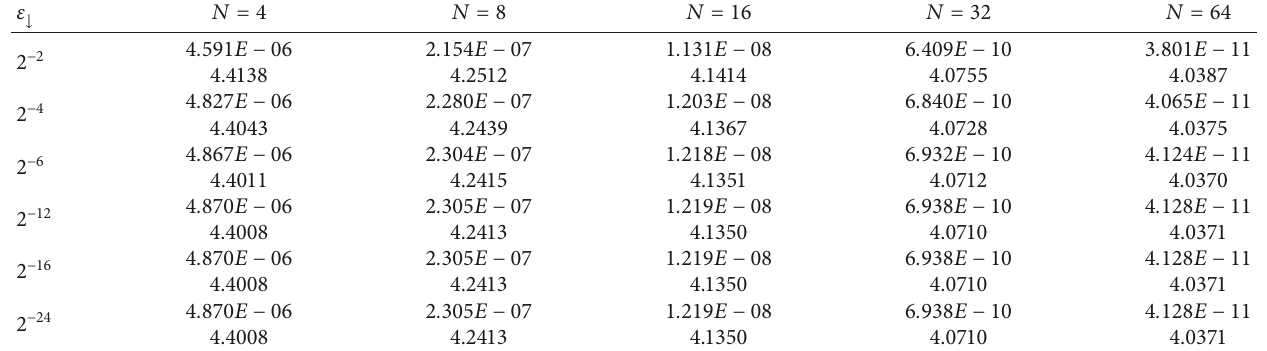
Table 4: Result for Example 4 (max. errors and rate of convergences for δ � η � 0 . 5 ∗ ε ).